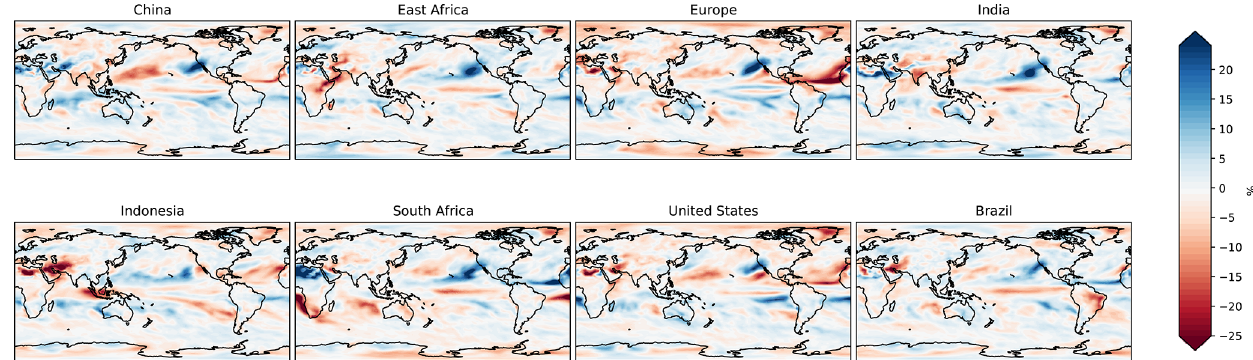
Figure A6. Annual-mean precipitation responses to identical total aerosol emissions within each of the eight perturbation regions are given in terms of percent change relative to the climatological precipitation in each grid cell taken from the control simulation.